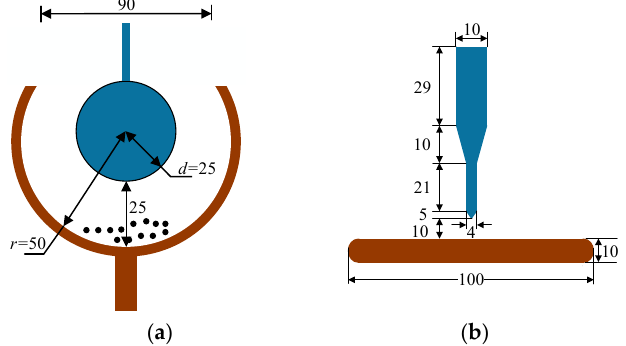
Figure 2. Dimensional structure of defect model: ( a ) Free metal particles defect and ( b ) metal protrusion defect (Unit: mm).